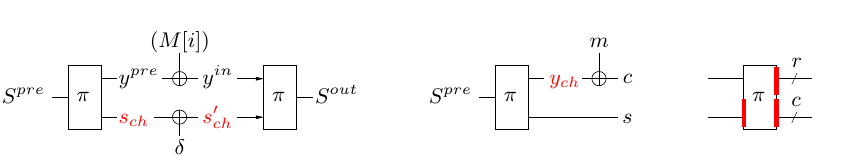
Figure 3: (Left) Illustrating the Inv [ ω ] assumption. The value in red (i.e., s ch ) is the critical secret. The involved values are as defined with Eq. (3), while the values S pre and S out are only mentioned in the subsequent security tester. (Middle) The “basic” message manipulating operation. The value y ch in red is the secret. (Right) A summary: which values should be somehow ensured secret (i.e., the lsb ω bits of the input, and the entire output, as stressed by the red bold